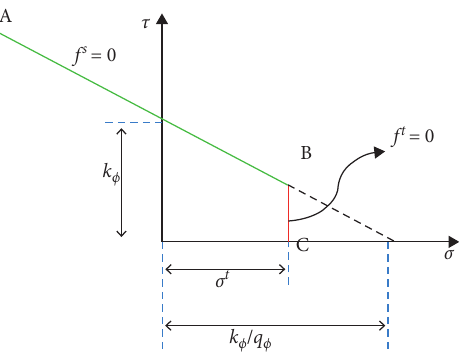
Figure 18: The Drucker–Prager failure